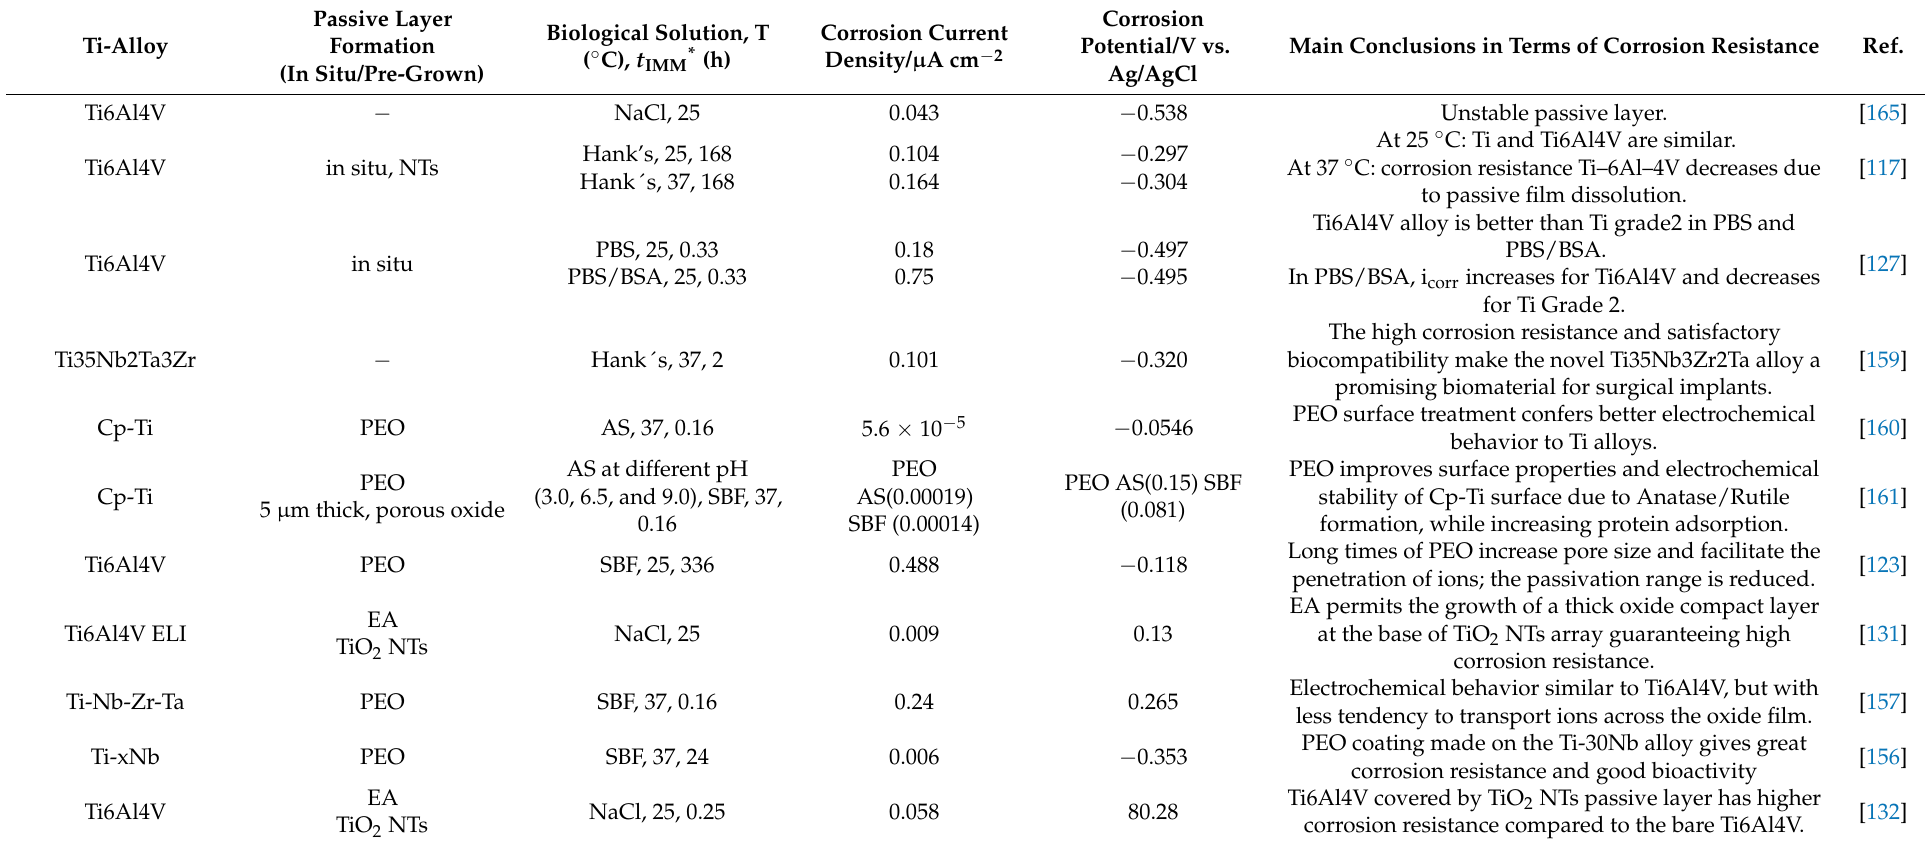
Table 3. Summary of the corrosion properties of passivated (spontaneous, in situ, or pre-formed oxide coating) Ti-6Al-4V and β -Ti alloys in different fluids.